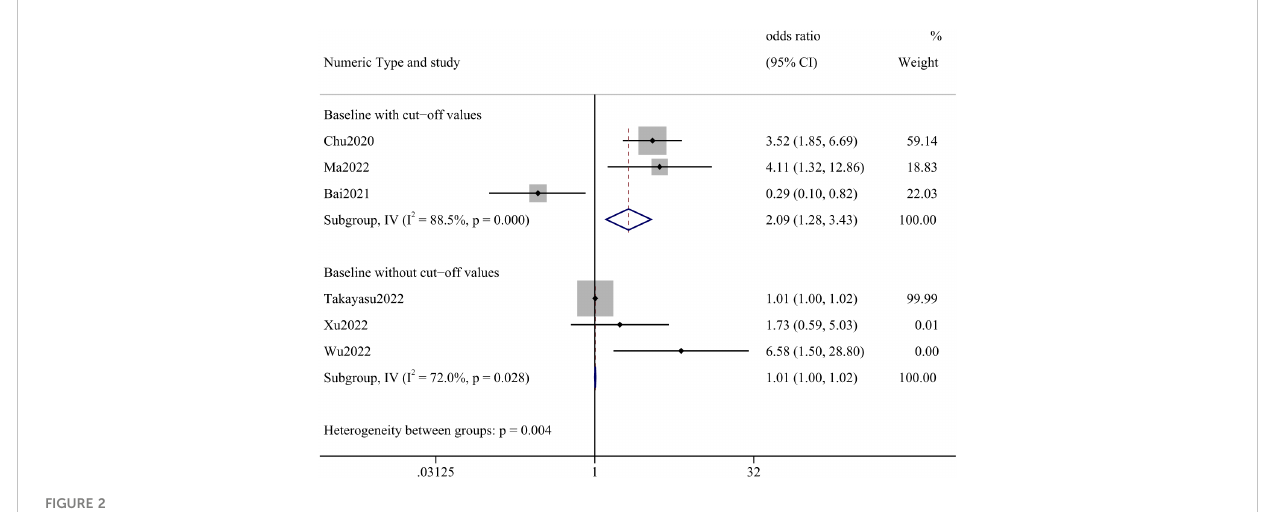
FIGURE 2 Forest plot of correlation between AEC and incidence of